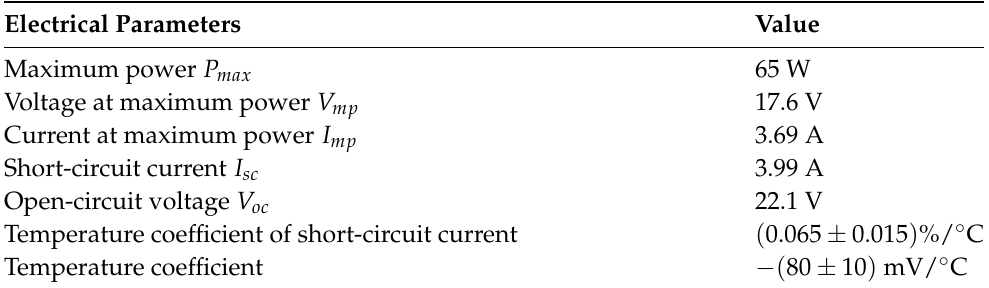
Table 4. Electrical characteristics of Pv module BP